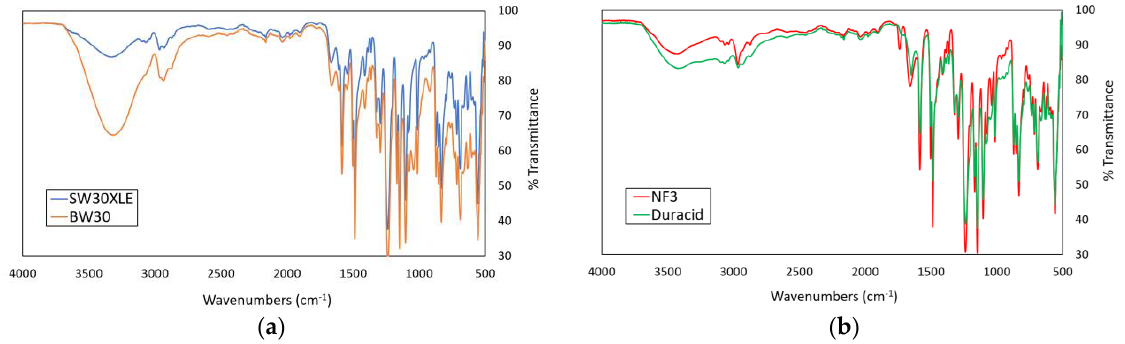
Figure 2. The ATR-FTIR spectra of different membranes, ( a ) SW30XLE and BW30 (RO type) and ( b ) NF3 and Duracid (NF type).